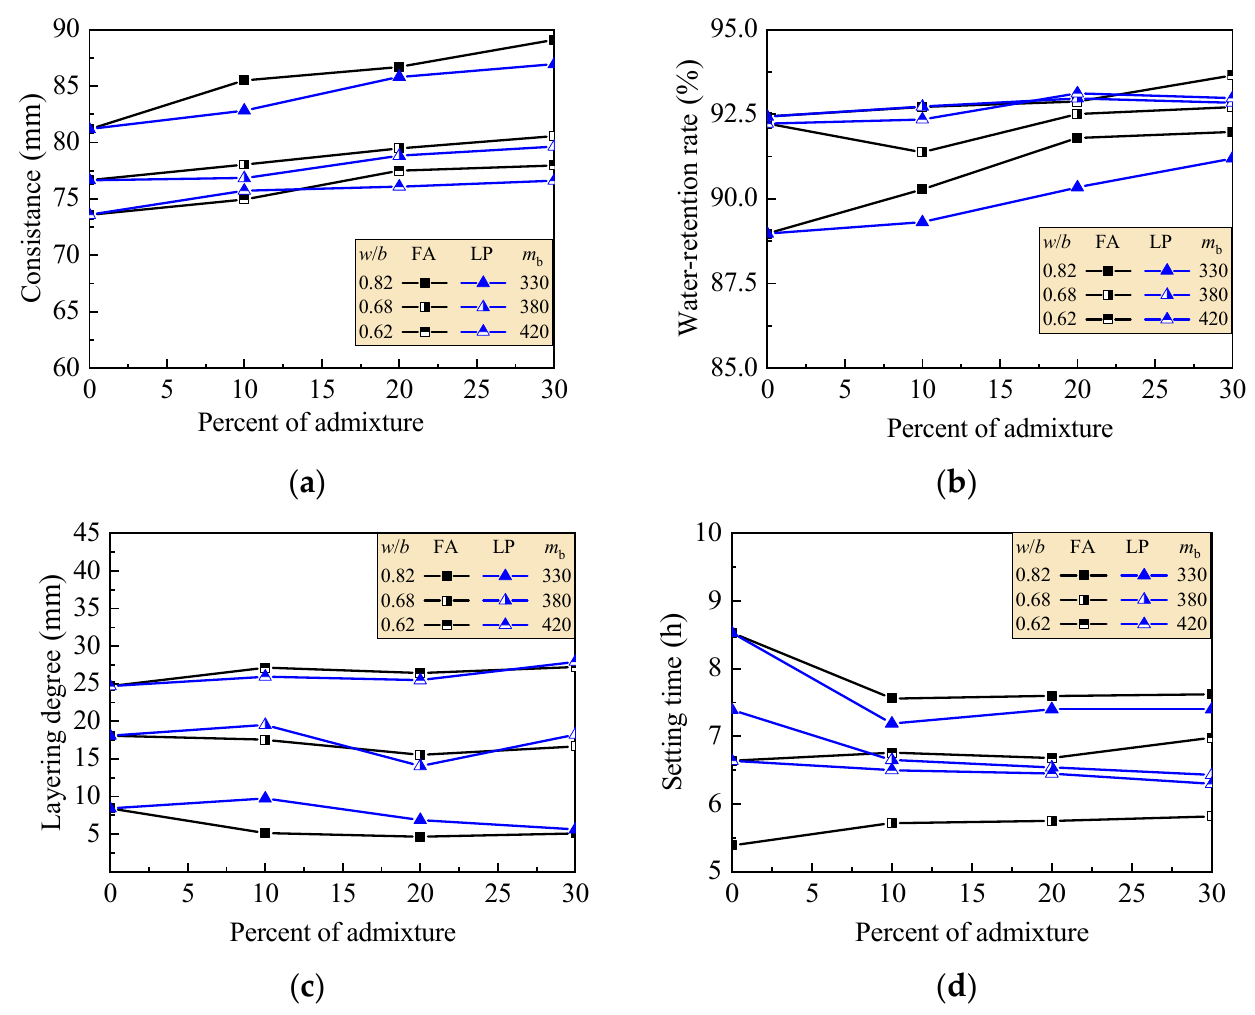
Figure 2. Test results of workability of fresh mortars: ( a ) consistency; ( b ) water-retention rate; ( c ) layering degree; ( d ) set- ting